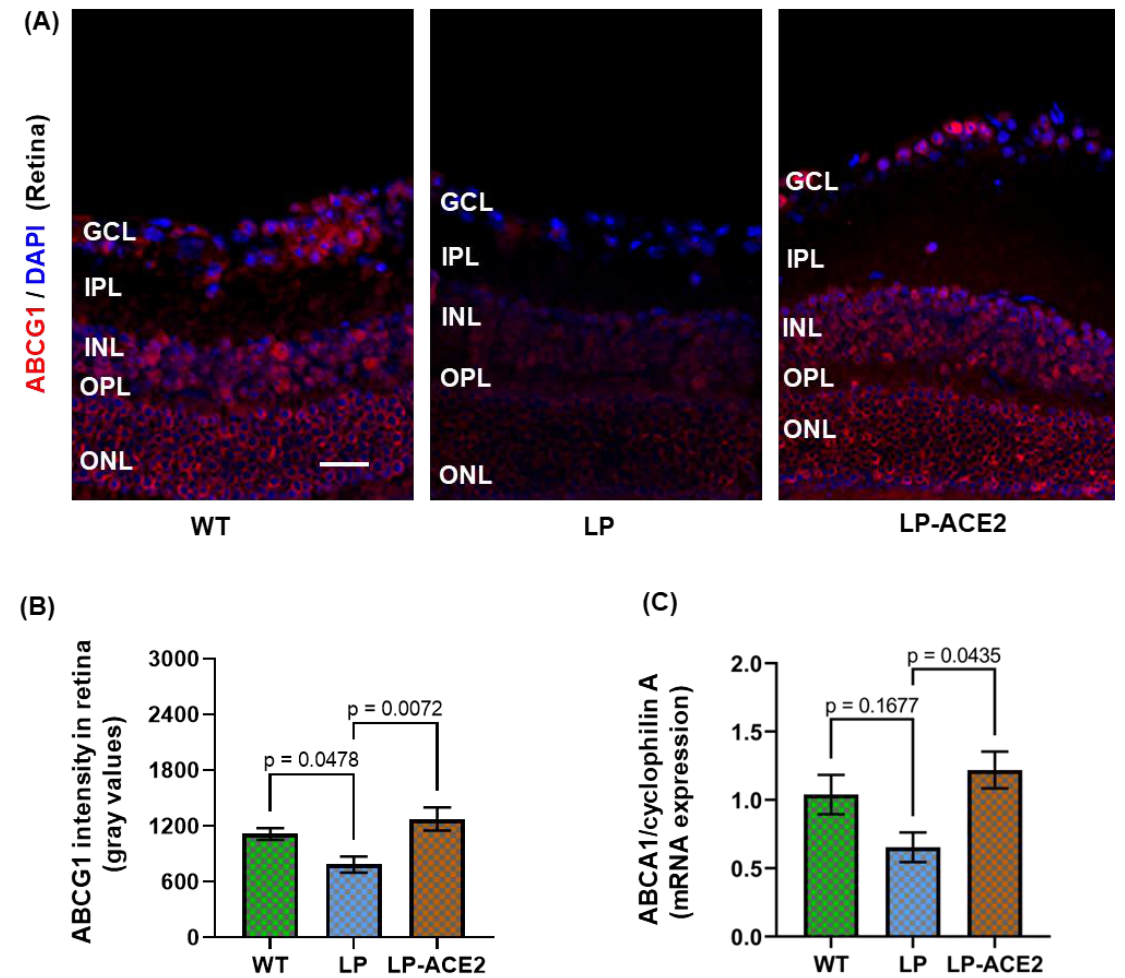
Figure 3. LP-ACE2 restores the reverse cholesterol transport pathway in Akita mice. Representative images of ABCG1 (red) expression in the retina of WT and Akita mice ( A ). The expression level of ABCG1 fluorescence was quantified and presented as mean intensity of gray values ± S.E.M of gray values ( B ). The mRNA expression of ABCA1 is quantified by qRT-PCR and normalized with house- keeping gene cyclophilin ( C ). Data are analyzed by one-way ANOVA adjusted to account for mul- tiple comparisons using Tukey’s test. Scale bar = 25 μm ( n = 6).